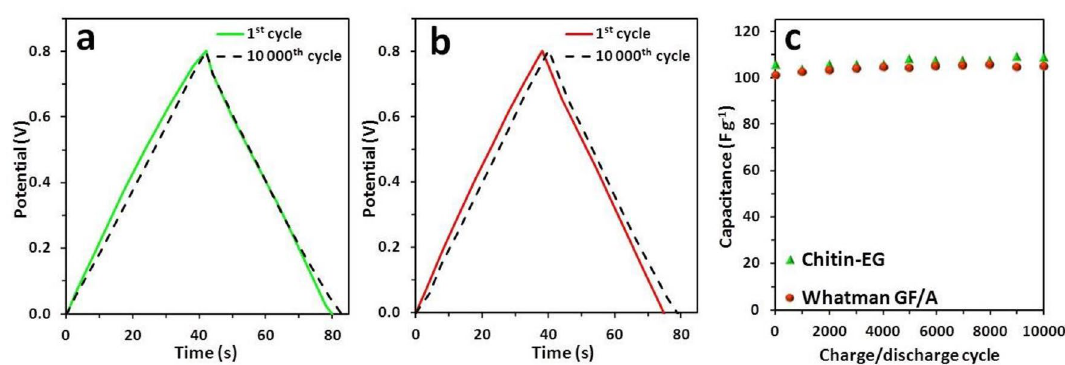
Figure 9. Galvanostatic charge/discharge curves at the 1st and 10,000th cycle for EDLC test cells with ( a ) chitin–EG hydrogel and ( b ) Whatman GF/A glass fiber separator. ( c ) Cyclic stability over 10,000 cycles for tested EDLC